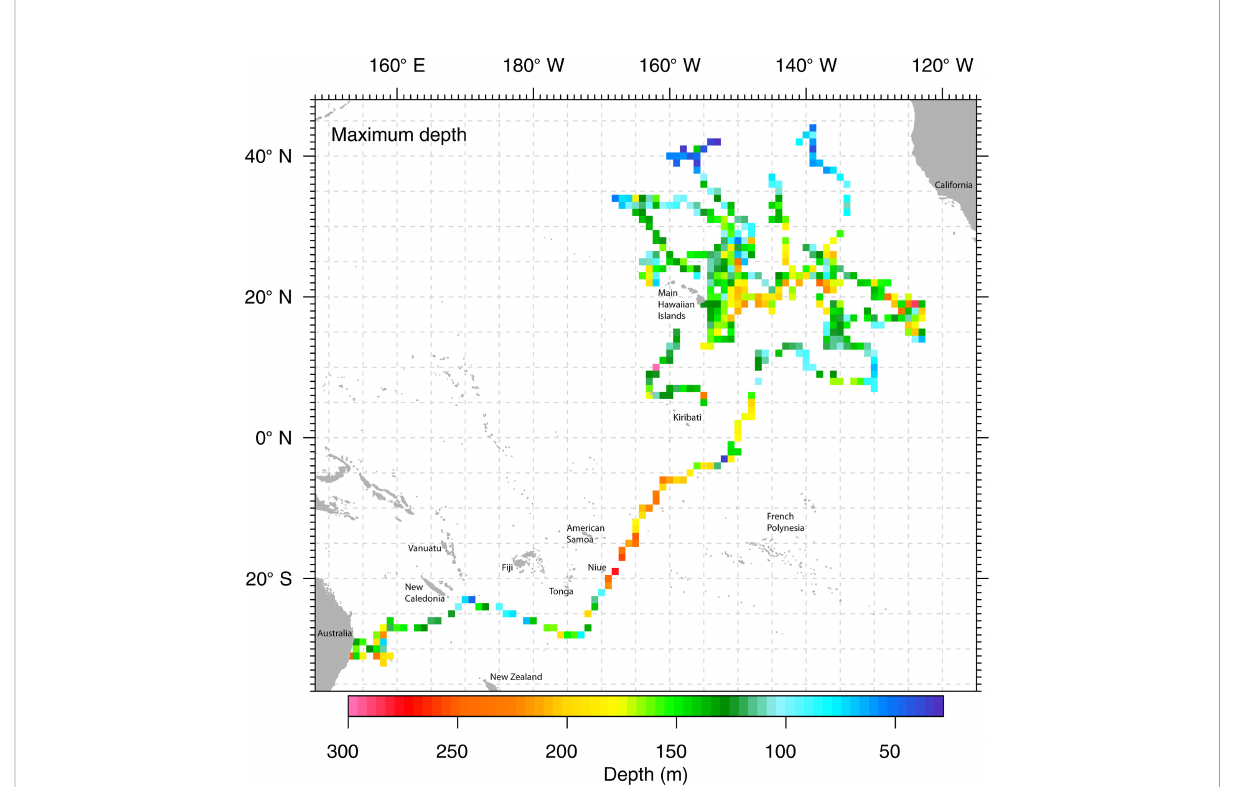
FIGURE 3 Maximum depth of striped marlin along their dispersal tracks. Tag-recorded maximum depths are binned in a 1°x1° grid and plotted in false color. When multiple values exist in a grid cell, the maximum value among them is